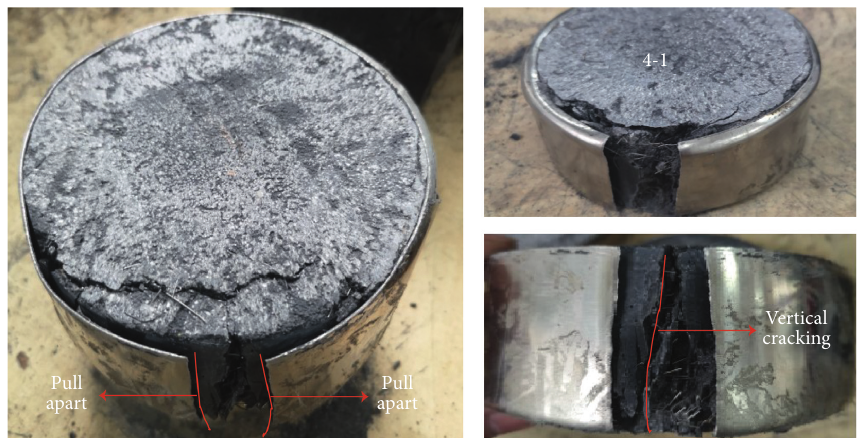
Figure 14: Failure mode of the fourth set of turntable